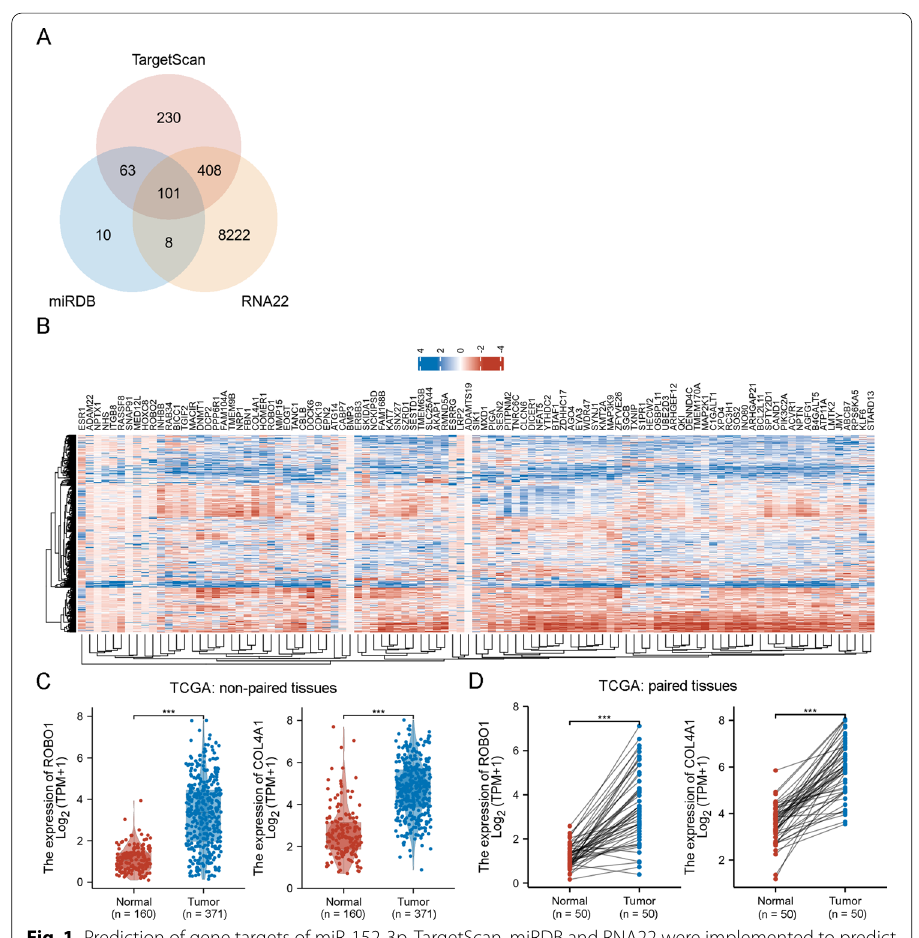
Fig. 1 Prediction of gene targets of miR-152-3p. TargetScan, miRDB and RNA22 were implemented to predict gene targets of miR-152-3p ( A ). Heatmap represents the differential expression of 101 gene targets ( B ). ROBO1 and COL4A1 expression in non-paired HCC tissues and non-tumour tissues ( C ). ROBO1 and COL4A1 expression in paired HCC tissues and adjacent tissues ( D ). *** p <